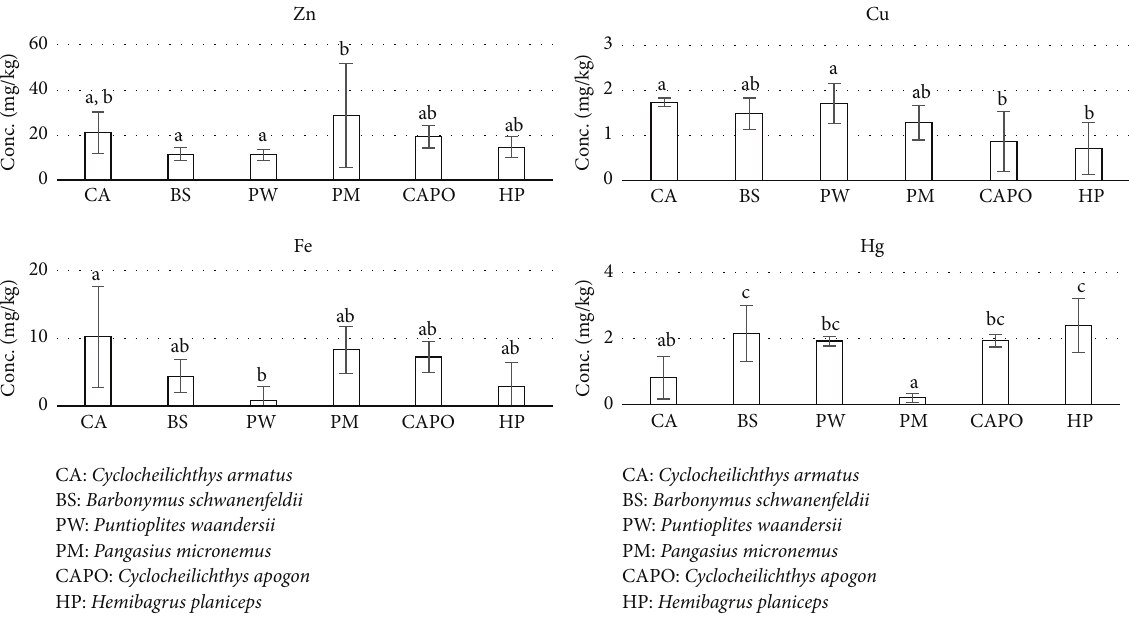
Figure 3: The average metal concentrations in fishes in dry